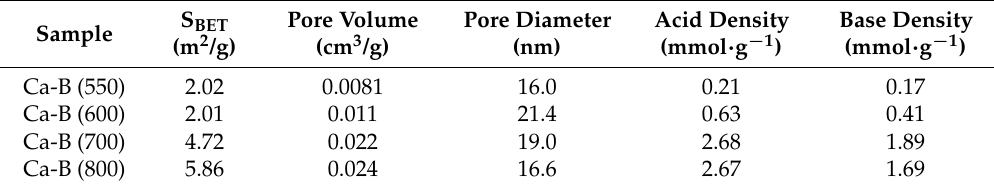
Table 1. Textural properties of different Ca-B